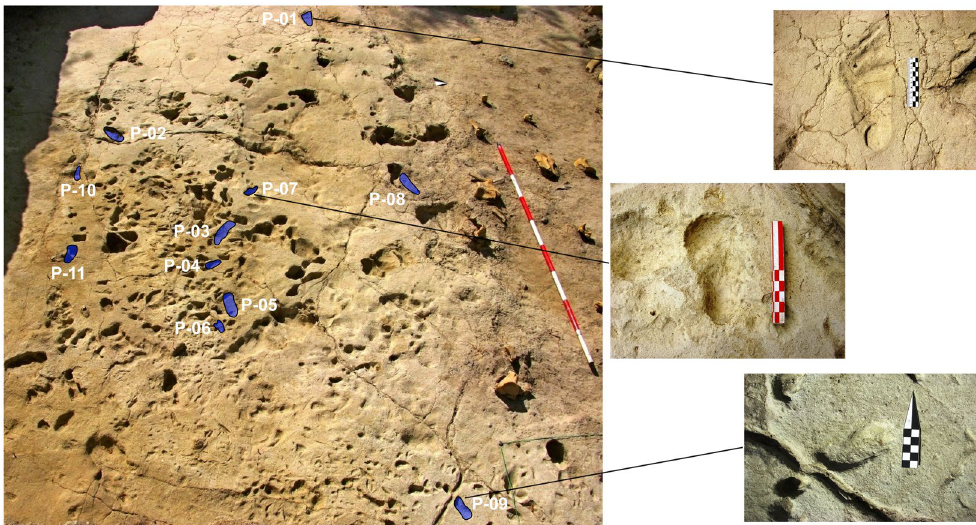
Figure 2. Overview of the densely-packed human and other animal footprints, with a close view of P-01 (adult hominin), P-07 and P-09 (both produced by a young